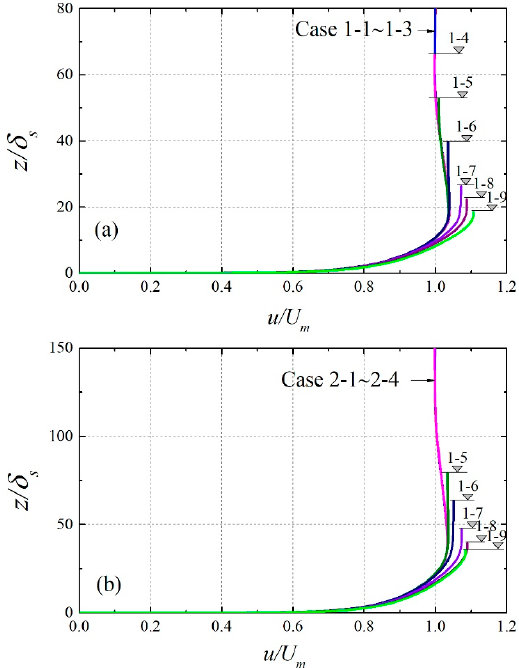
Figure 3. Velocity profile under wave crest ( σ t = π /2). ( a ) Re = 3.51 × 10 6 , ( b ) Re = 1.99 × 10 7